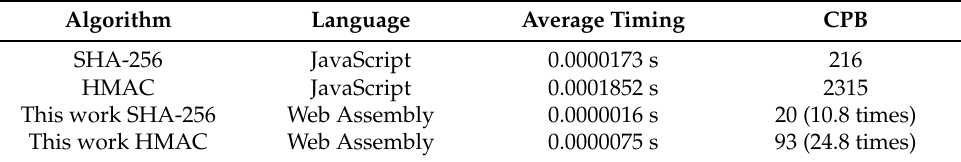
Table 17. HMAC algorithm performance in Firefox ( CPB : Cycle Per Byte).